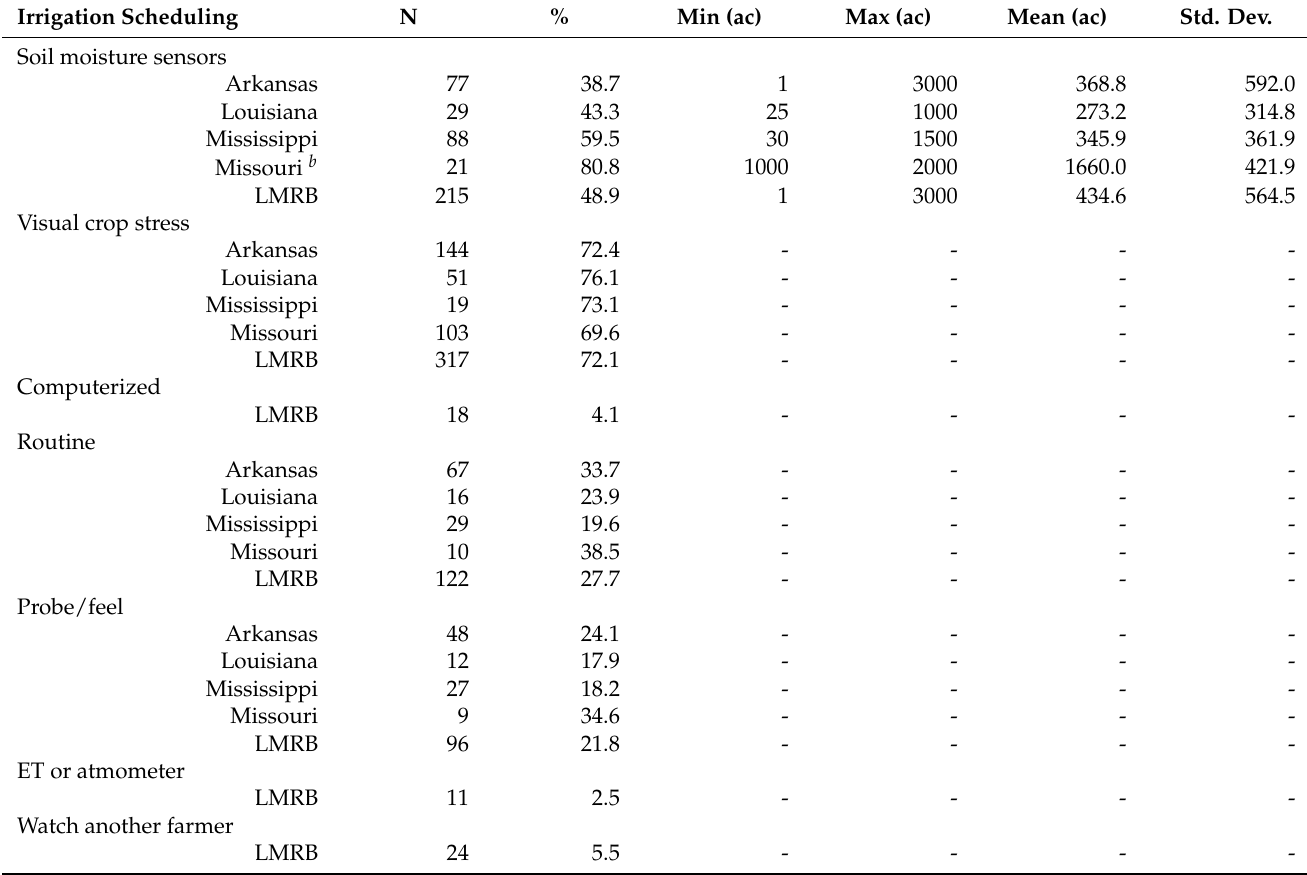
Table 7. Summary statistics of irrigation